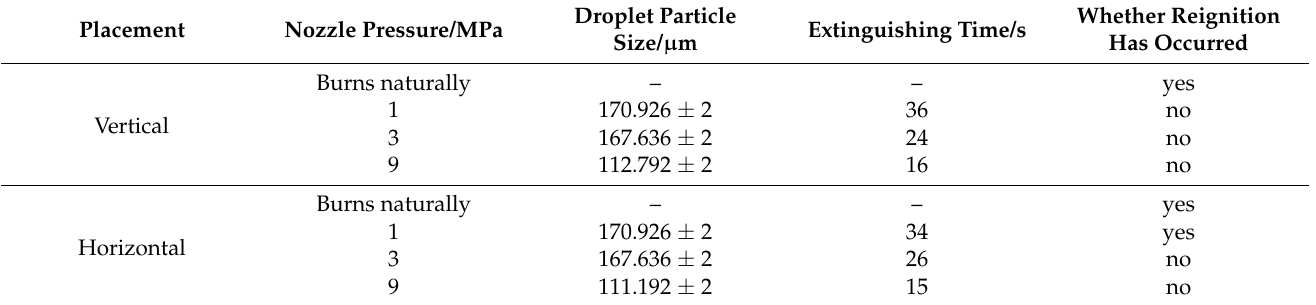
Table 2. Fire extinguishing results from water mist under different